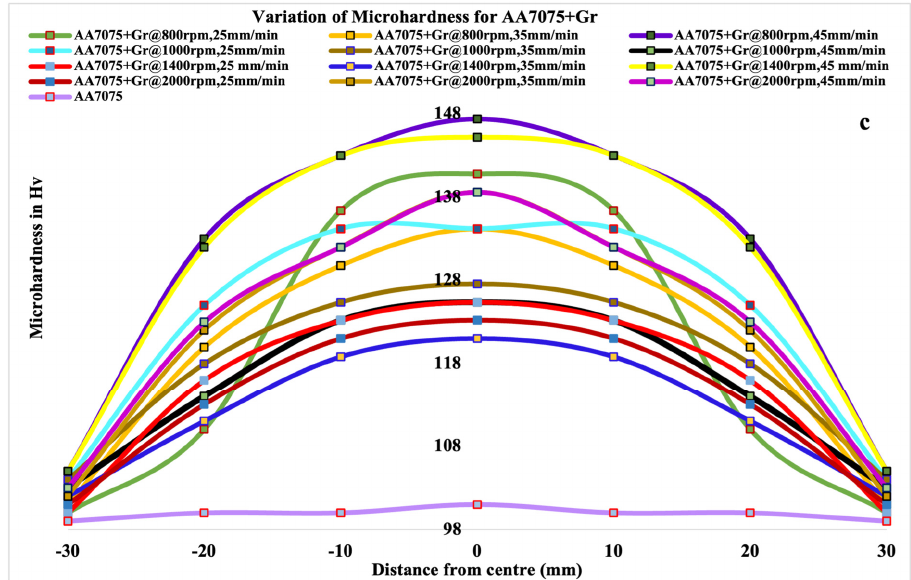
Figure 9. Micro-hardness profiles of AA7075 with ( a ) nB 4 C, ( b ) nTiO 2 , and ( c ) nGr FSPed . Figure 10. Micro-hardness profiles of AA7075 with ( a ) nB 4 C, ( b ) nTiO 2 , and ( c ) nGr In comparison to surface composites produced at rotating speeds (1000, 1200, and 1600 rpm), the micro-hardness of AA7075/TiO 2 surface composites produced under these conditions revealed a value of 149.6 HV. When compared to the plots for base metal, micro hardness in this instance increased by 48.8% (101 HV). With a feed rate of 35 mm/min and a rotational speed of 1000 rpm, the micro-hardness of the AA7075/B 4 C surface composite measured 156 HV, which is considerably higher than the values for the surface composites produced at rotational speeds of 800, 1400, and 2000 rpm. As compared to base material, micro-hardness in this instance rose by 54.5% (101 HV).